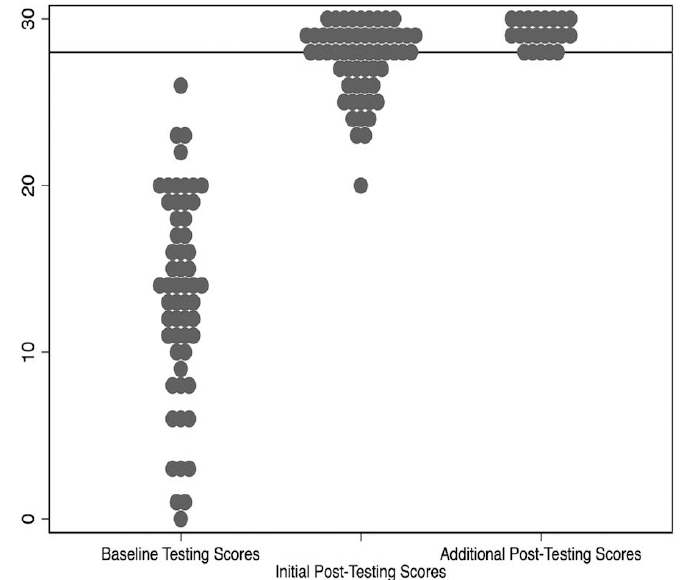
Figure 2. Distribution of checklist scores during each phase of testing. Vertical axis depicts checklist score (maximum score 30). Horizontal line represents the minimum passing standard (MPS) of 28/30. Additional post-testing scores represent the 21 learners who did not meet the MPS during initial